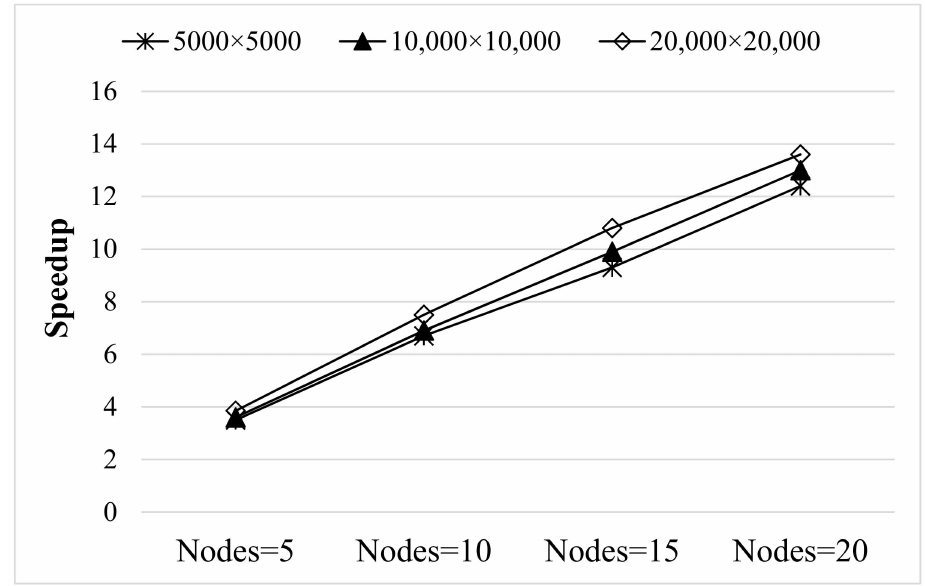
Figure 13. Speedup of PARSUC with di ff erent number of nodes.